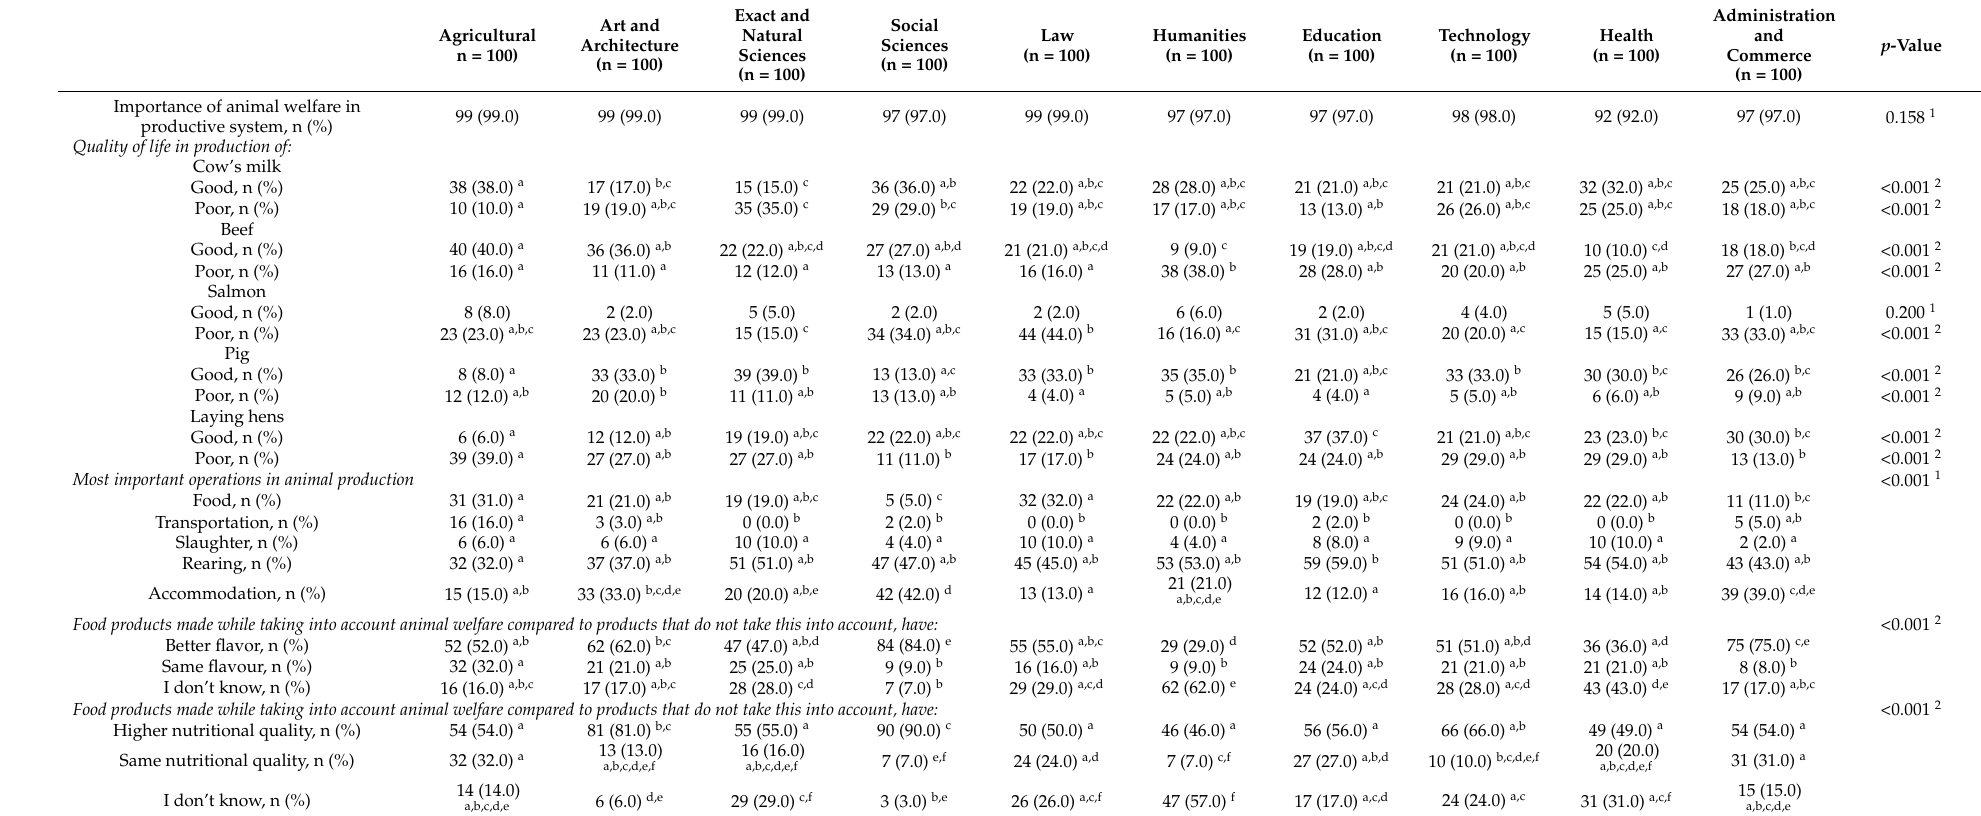
Table 5. Perceptions toward animal welfare of Chilean university students from different